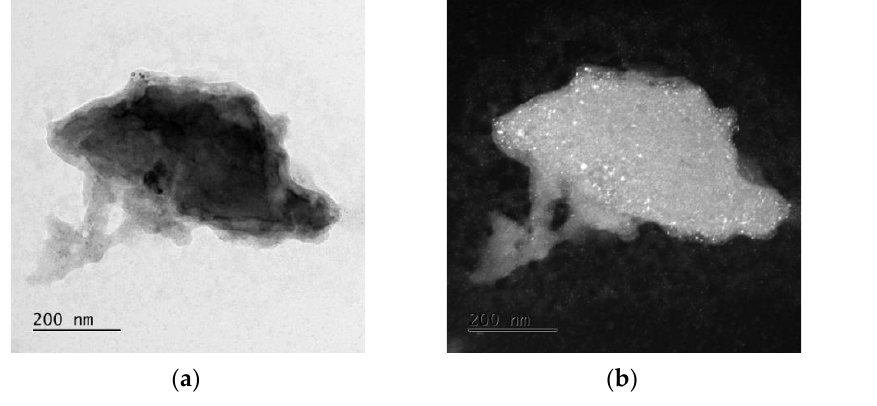
Figure 7. TEM images for Mg 65 Zn 30 Ca 4 Ag 1 milled for 70 h. ( a ) Bright field image, ( b ) dark field image, ( c ) SAED pattern from tested region.